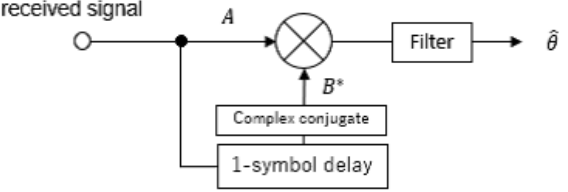
Figure 3. Delayed detection